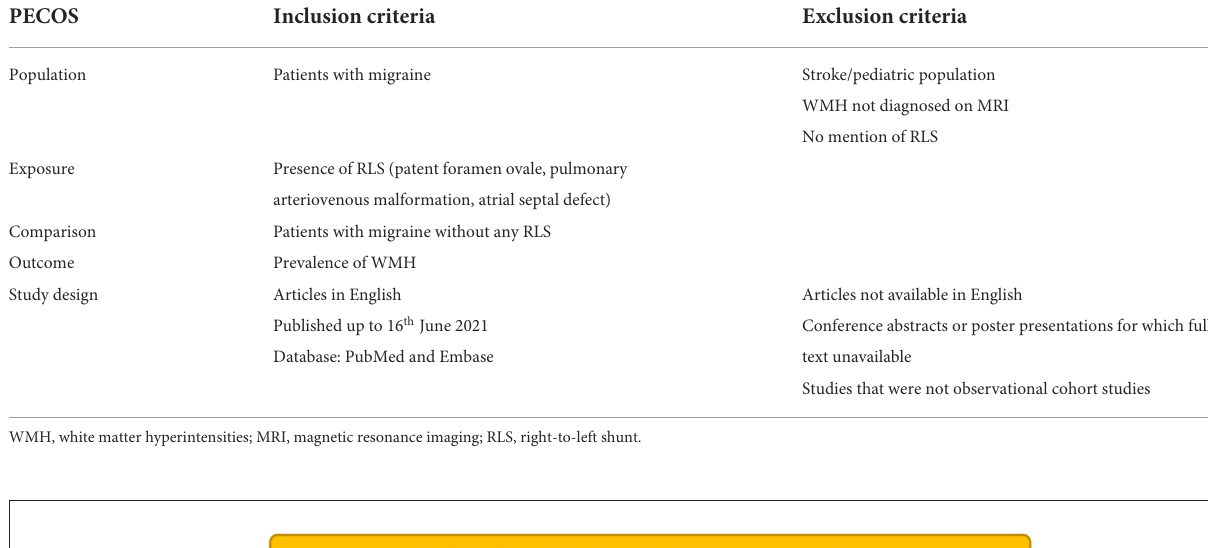
TABLE 1 PECOS (Population Exposure Comparison Outcomes Study Design) table.